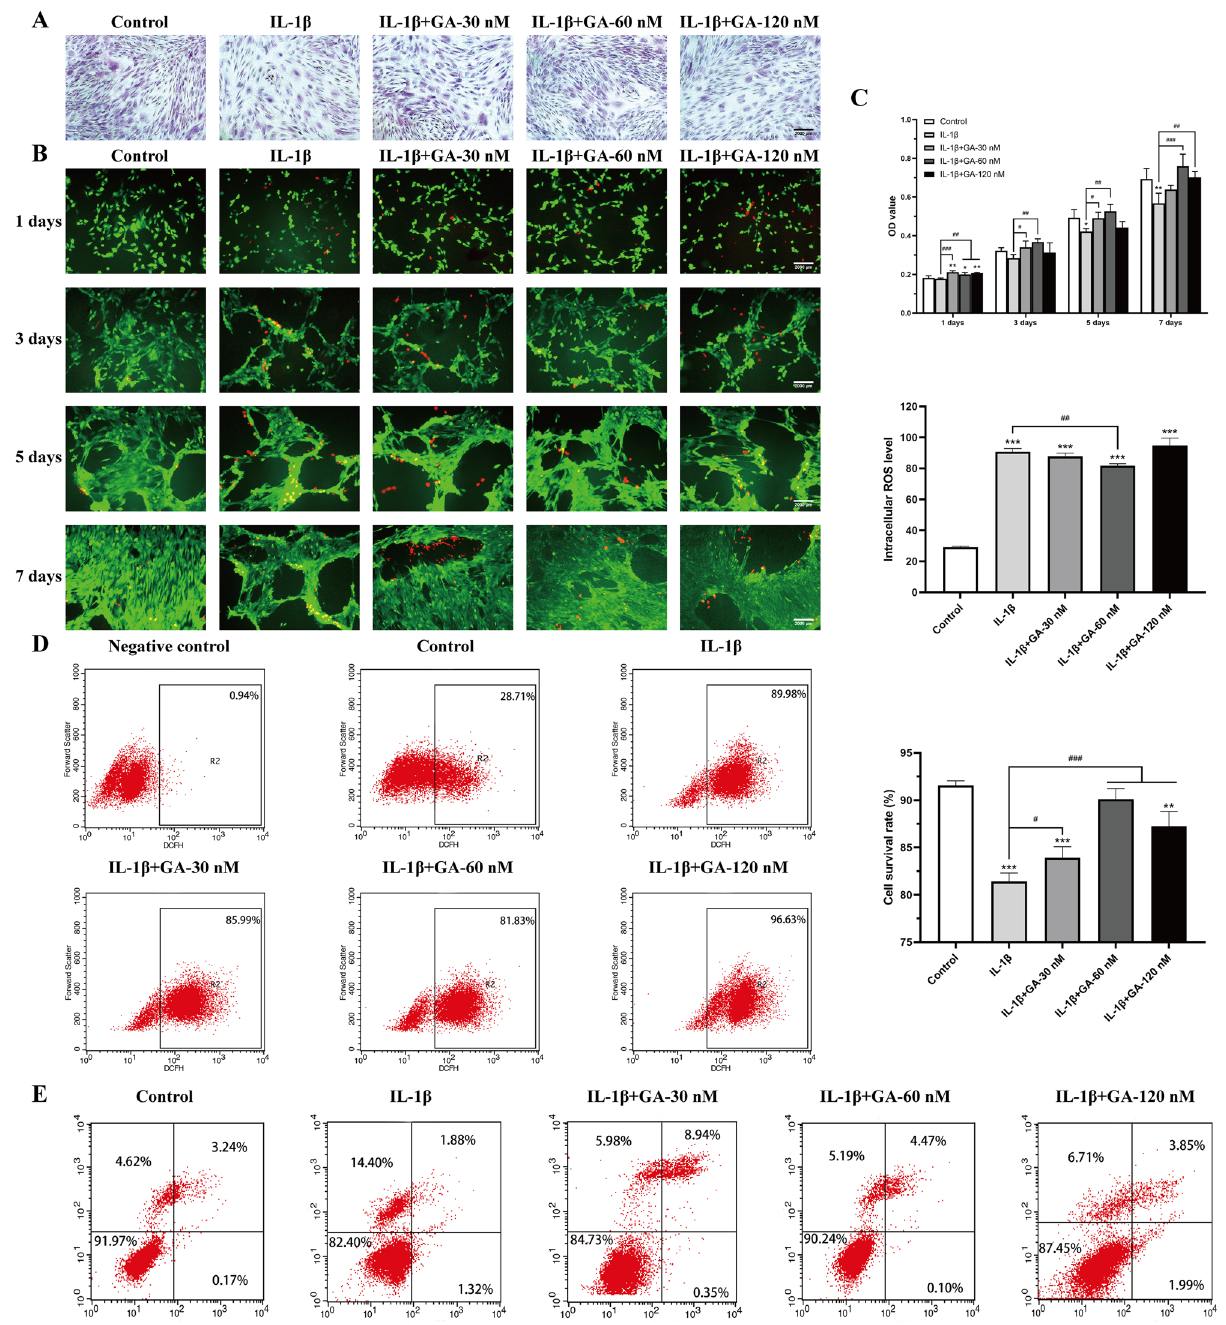
Figure 3. Protective effects of His6-GABARAP on IL-1β-induced BMSCs. H&E ( A ), FDA/PI staining ( B ), MTT assay ( C ), and Flow cytometry ( D , E ) were applied for cell morphology, viability, proliferation, and intracellular ROS. Control (without IL-1β); IL-1β (with 10 ng/mL IL-1β); IL-1β + GA-30 nM (with 10 ng/mL IL-1β and 30 nM His6-GABARAP); IL-1β + GA-60 nM (with 10 ng/mL IL-1β and 60 nM His6-GABARAP); IL-1β + GA-120 nM (with 10 ng/mL IL-1β and 120 nM His6-GABARAP). Values are presented as means ± SD, n = 3. * p < 0.05, ** p < 0.01, *** p < 0.001 relative to the control group; # p < 0.05, ## p < 0.01, ### p < 0.001 relative to the IL-1β group. Scale bar, 2000